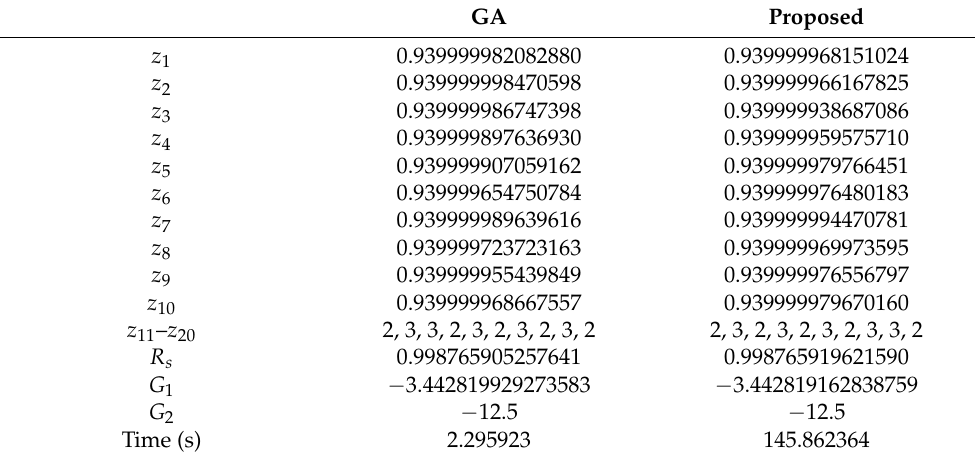
Table 1. Optimal solutions of the Lin/Con/2/10:F system.